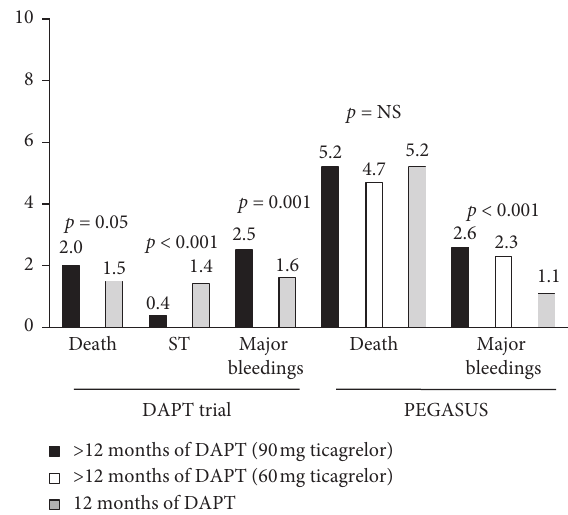
Figure 3: Bar graph showing the rate of major clinical events in clinical trials comparing 12-month dual antiplatelet strategy (DAPT) vs. a longer ( > 12 months)